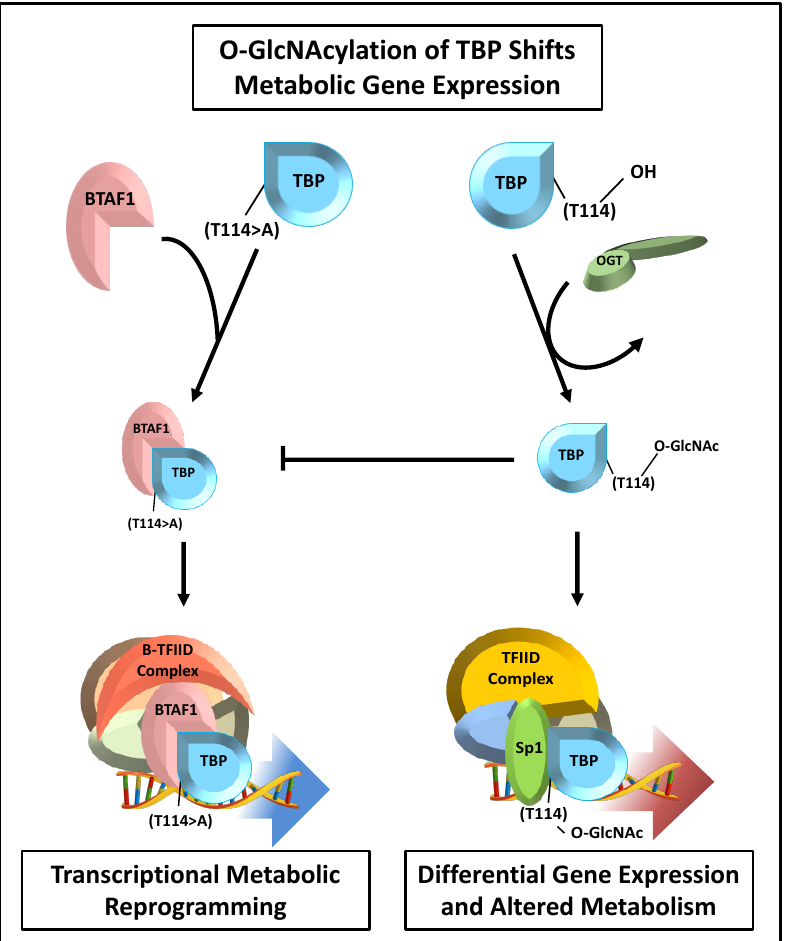
Figure 3. O-GlcNAcylation of TBP regulates metabolic gene expression. O-GlcNAcylation of TBP at the amino acid residue T114 impairs B-TFIID complex formation by disrupting BTAF1 binding. Disruption of TBP O-GlcNAcylation results in significant metabolic transcriptome reprogramming, leading to a profound alteration in lipid storage. Using O-GlcNAc as a nutrient sensor, cells can fine-tune the metabolic transcriptome. Dysregulation of O-GlcNAc signaling has catastrophic effects on metabolic gene